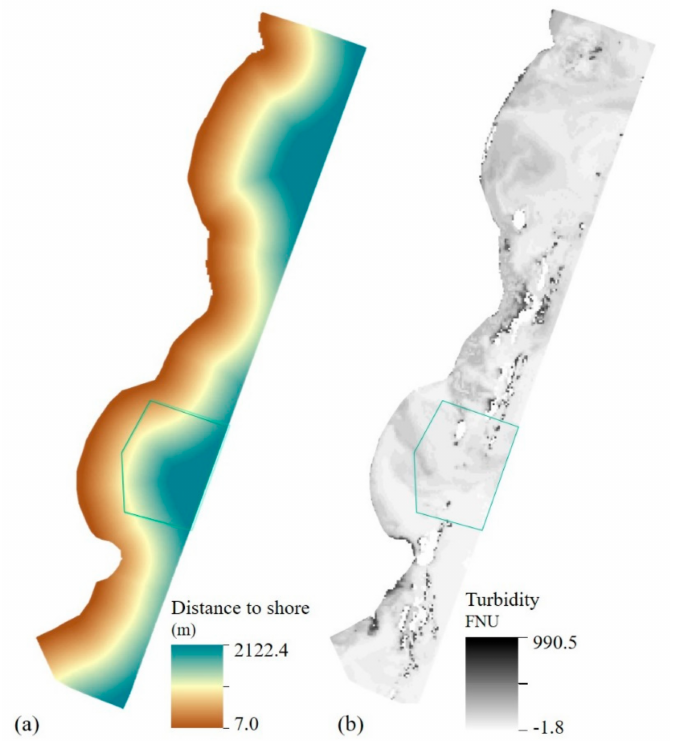
Figure 8. Local layers used as environmental variables in the predictive modeling of Millepora alcicornis . The hollow blue polygon on the images shows the location of the no-take zone. ( a ) Distance to shore; ( b ) relative measures of turbidity in formazin nephelometric units